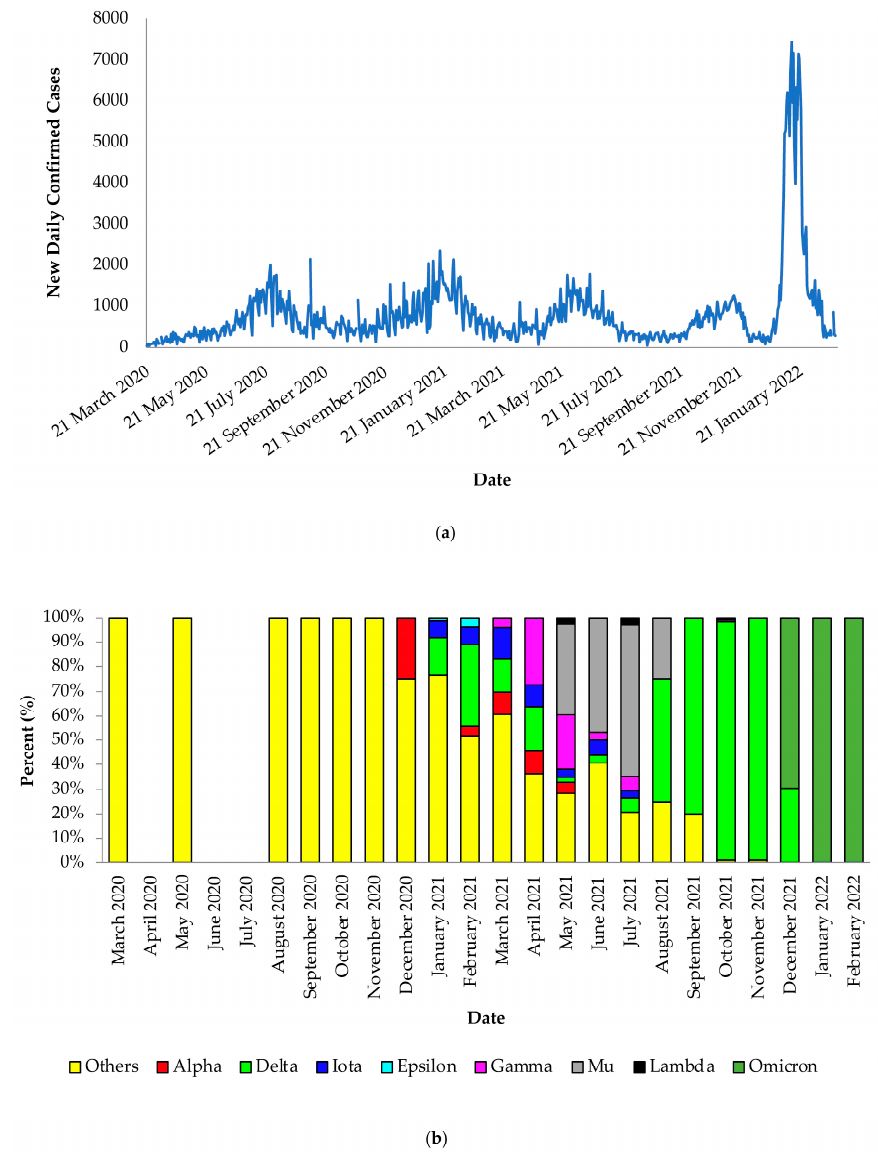
Figure 2. Daily SARS-CoV-2 confirmed cases and variant distribution between March 2020 and February 2022. ( a ) The daily reported trends were obtained using 91-DIVOC (https://91-divoc.com/pages/covid-visualization/ (accessed on 5 May 2022). ( b ) The full genome nucleotide sequences and their genotyping details were obtained from the Global Initiative on Sharing All Influenza Data (GISAID) database and Pangolin web application,